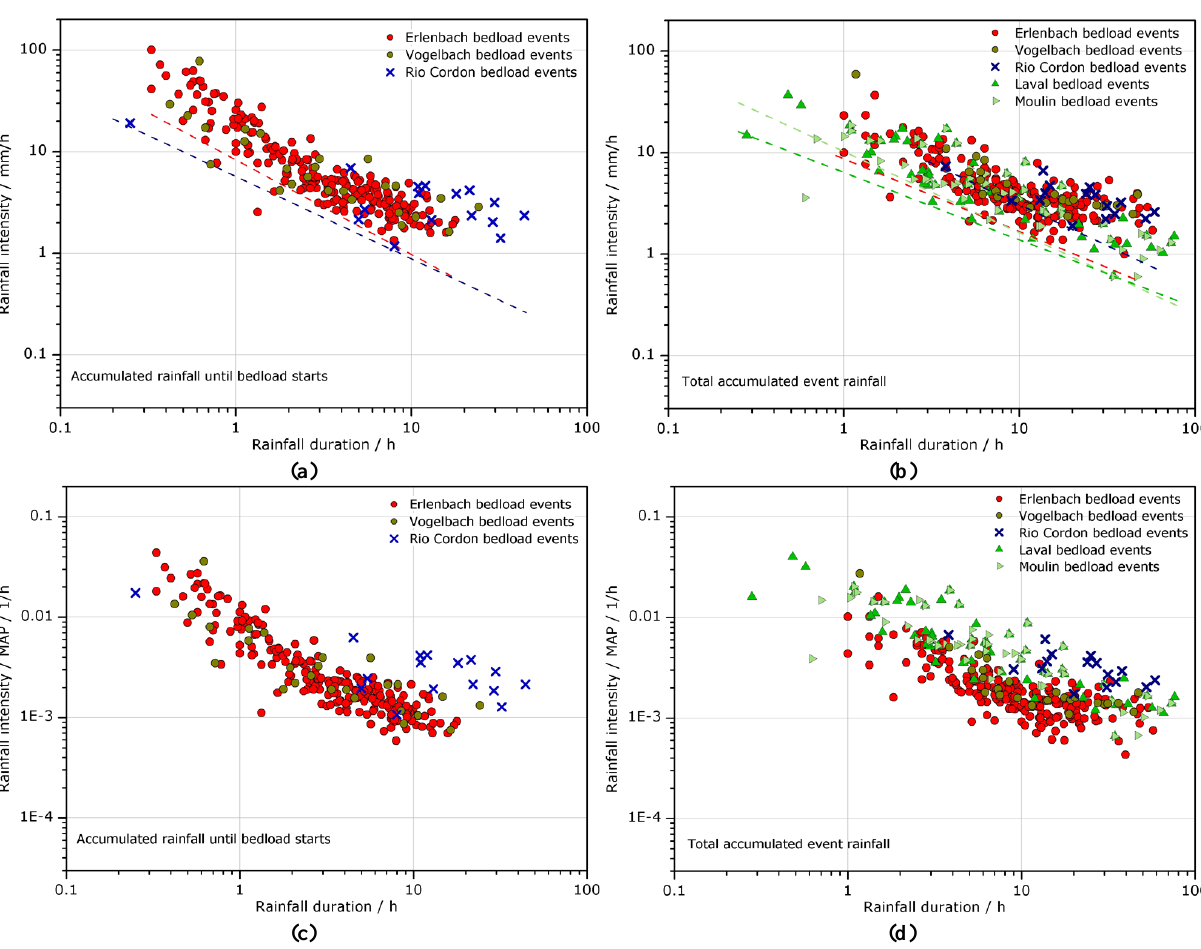
Fig. 6. Comparison of rainfall intensity–duration relationships in our study sites: (a) I BLS – D BLS relationships for rainfall (recorded until beginning of bedload transport) in the Erlenbach, Vogelbach and Rio Cordon catchments; (b) I T – D T relationships for total rainfall events associated with bedload transport in the Erlenbach, Vogelbach, Rio Cordon, Laval and Moulin catchments (the threshold lines are manually fitted); (c) and (d) show intensity data normalized by the mean annual precipitation MAP for rainfall until beginning of bedload transport and for total event rainfall related to bedload transport,